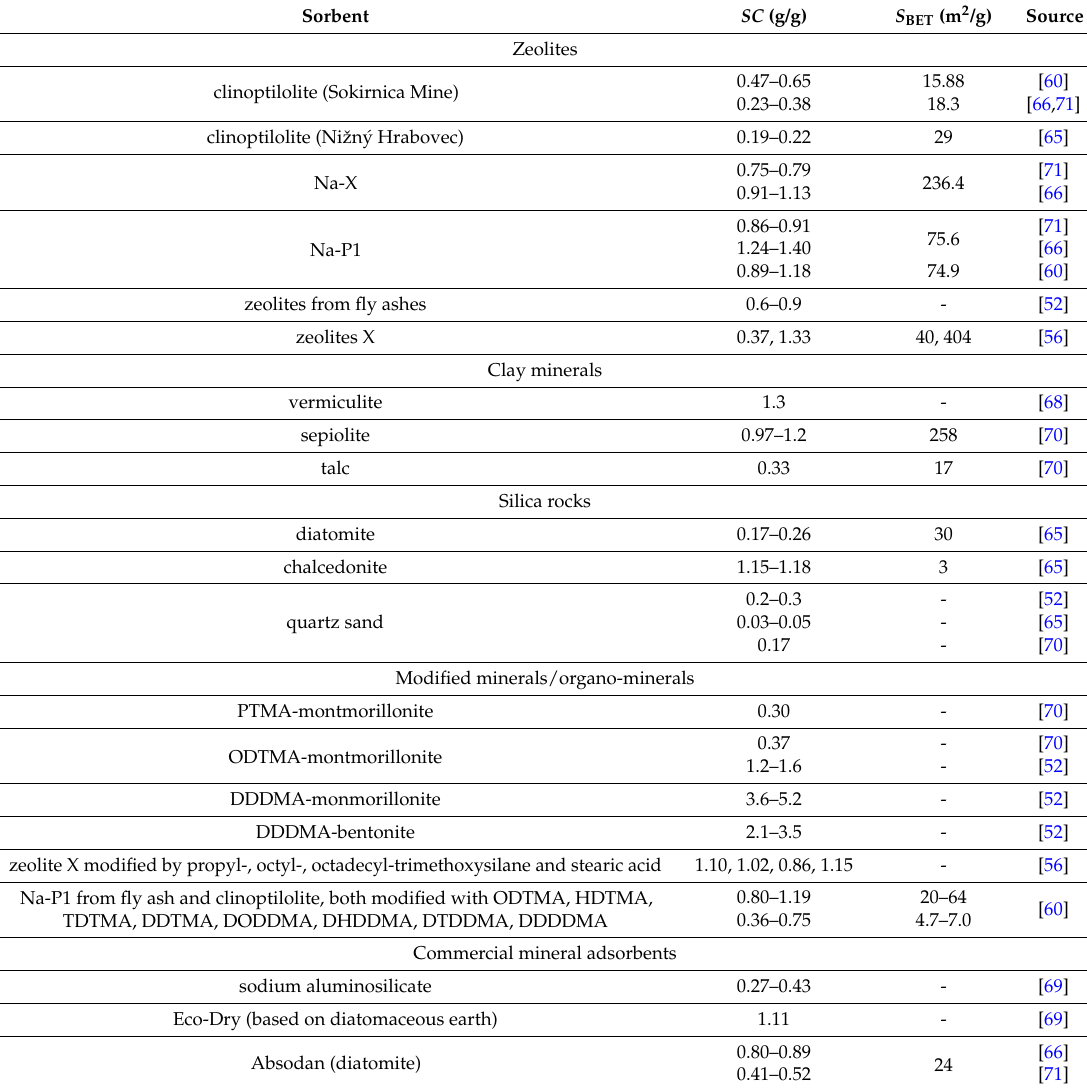
Table 1. Sorption capacities ( SC ) of mineral and organo-mineral adsorbents towards petroleum substances in the form of